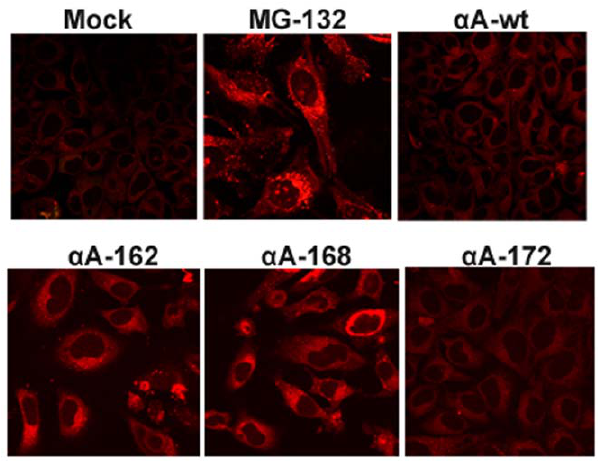
Figure 9. Detection of Aggresomes in individual expression of truncated a A in HeLa cells. Bright punctate staining in the perinuclear region for aggresomes was evident in a A162 and a A168 individually expressed cells. The proteasomal inhibitor, MG132 was used as positive control which exhibited a dramatic increase in punctate fluorescent staining in the perinuclear or juxta-nuclear region of the microtubule organizing center (MTOC) of the cells, and there was no aggresomes in negative control cells treated with vehicle, DMSO. Aggresomal foci were not evident in either a Awt or a A172 expressed cells.